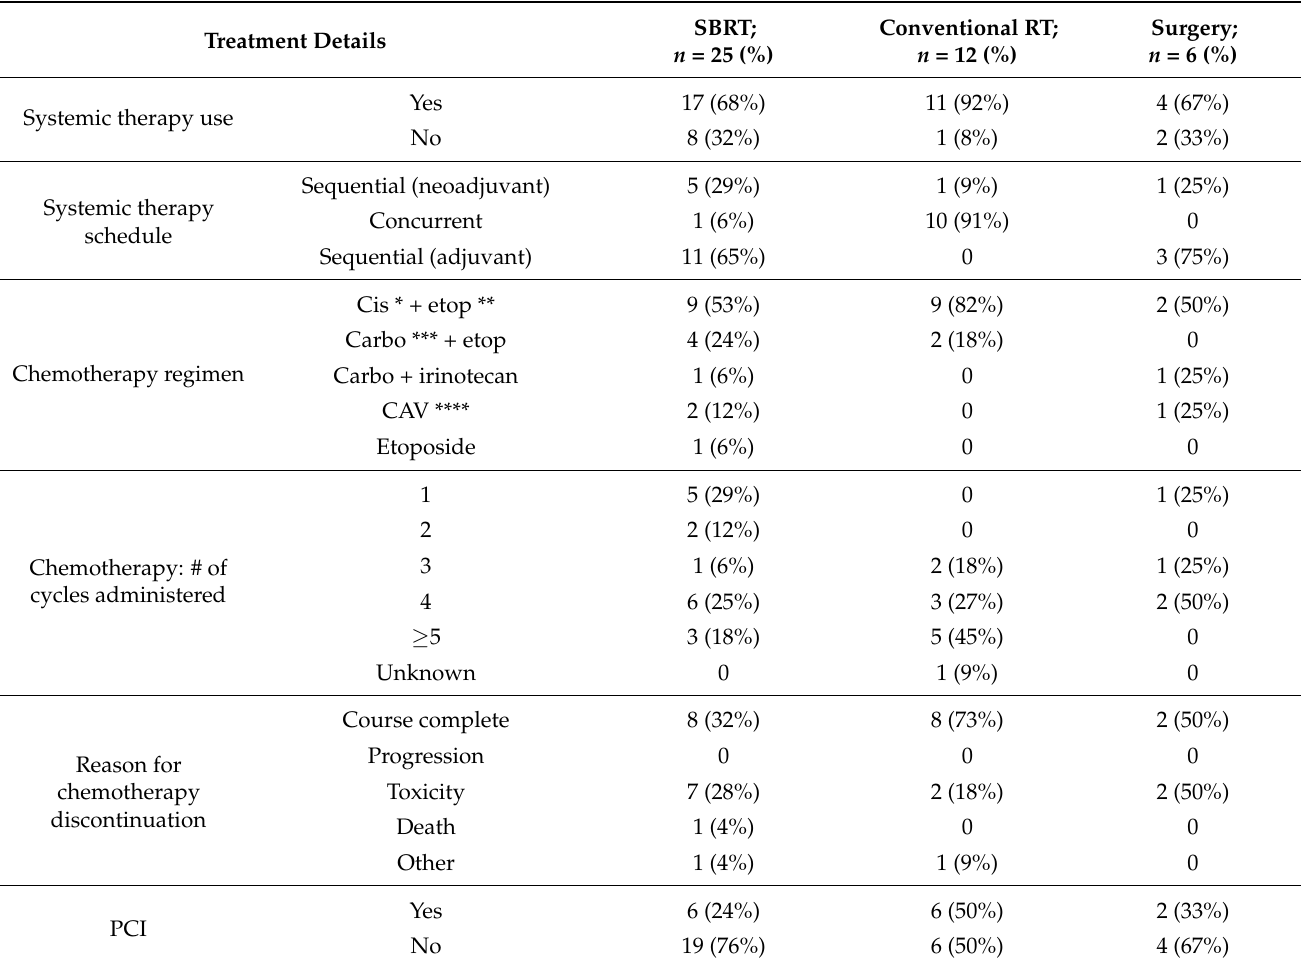
Table 3. Systemic therapy and